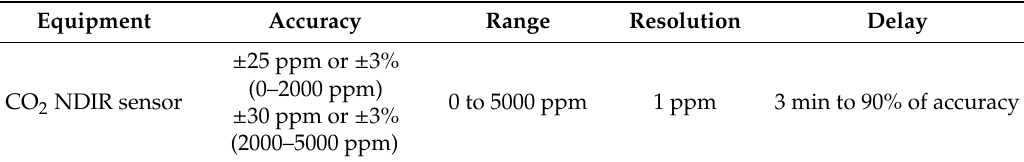
Table 4. Specifications of the equipment used in the experimental